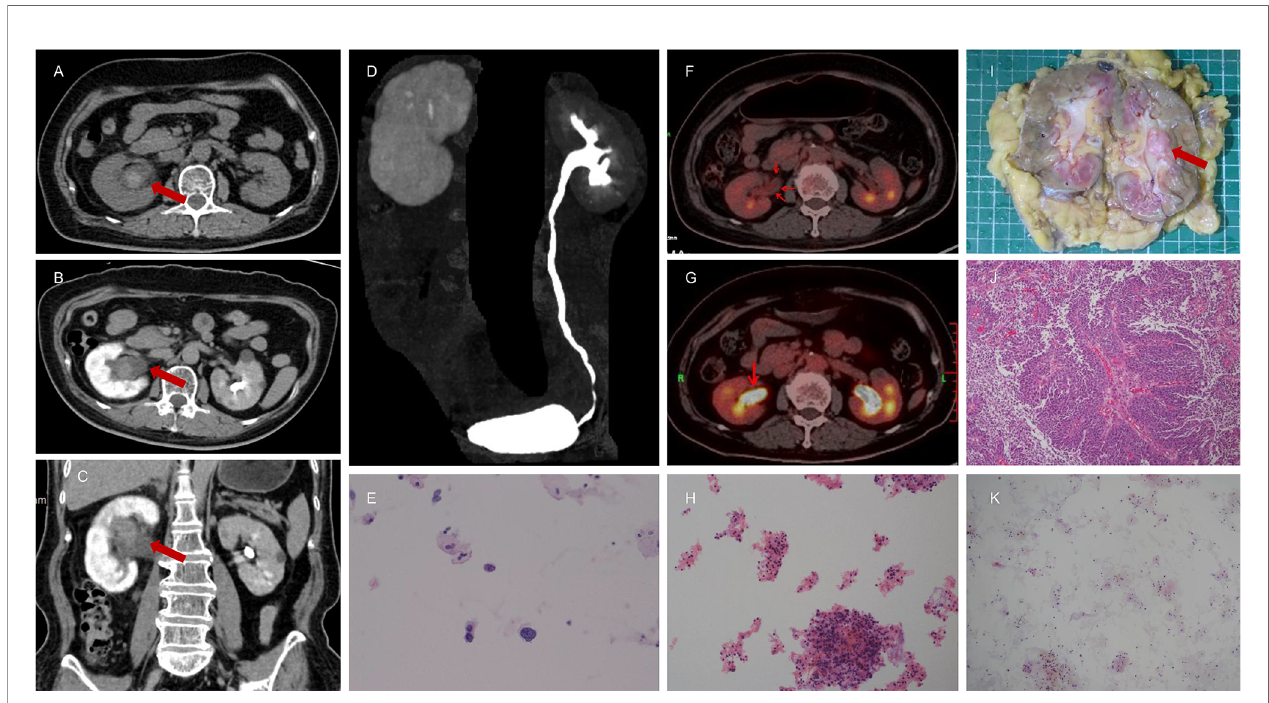
FIGURE 2 | A 67-year-old female presented with intermittent painless gross hematuria for 3 months. The results of CTU indicated hematomas or neoplastic lesion (1.9 cm * 1.4 cm * 2.9 cm) in the right renal pelvis due to clear boundaries, slightly high density, slightly homogeneous enhancement, the inconspicuous fi lling defect, and obviously dilated upper urinary tract (A – D) . Magnetic resonance imaging (MRI) also suggested benign lesions in the right renal pelvis. Nuclear heterogeneous cells were not found for one time (K) but there were few suspicious nuclear heterogeneous cells for two times (E, H) in the histopathological analysis of urine cytology. However, the NLR value was 3.45. Therefore, this patient was referred to the Department of Nuclear Medicine for 18F-FDG PET/CT. It demonstrated intense 18F-FDG uptake in right renal pelvis (F, G) . Combining NLR and 18F-FDG PET/CT, this patient was highly suspected to have a malignant tumor of renal pelvis and subjected to right RNU. The fi nal pathological report con fi rmed a diagnosis of right renal pelvic carcinoma (I, J)